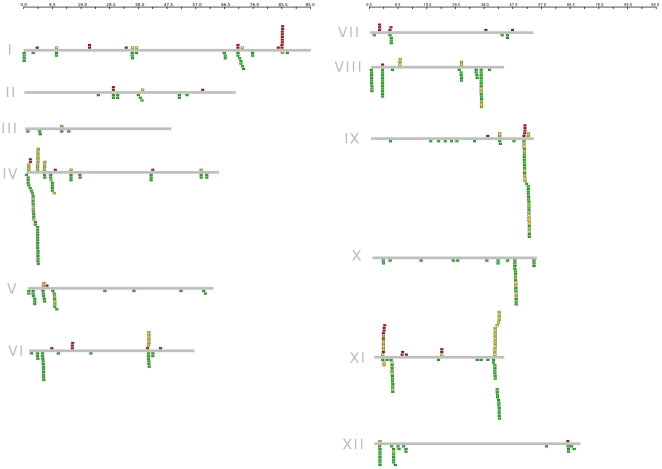
Distribution of Solanum tuberosum group phureja sequences that are predicted to encode NBS resistance proteins.Gray bars represent all 12 linkage groups in potato. Boxes across each bar designate the location of each gene. Color code: CNL (green), TNL (red) or a partial NBS gene (yellow). Distance in Megabases is shown at the top of each column.